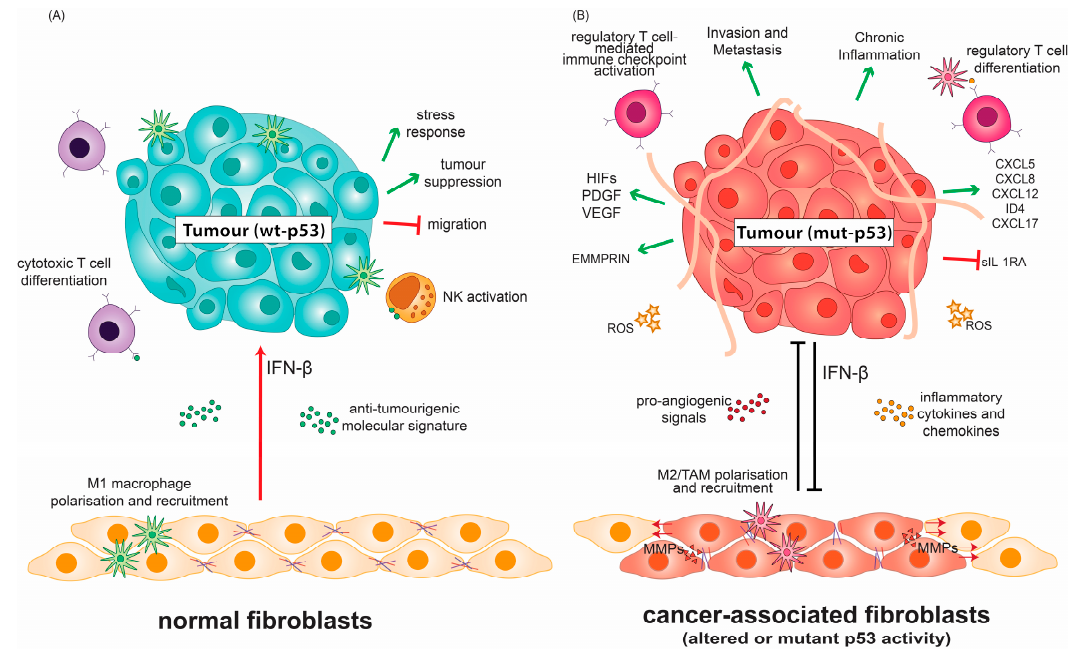
Figure 2. Mutant p53 alters its immunogenic niche. The tumour microenvironment is comprised of cellular and molecular components which shape the immune niche of the growing tumour. ( A ) Normal fibroblasts help mediate immunosurveillance by modulating anti-tumour immune cell infiltration and employing the IFN- β / p53 axis of regulation to activate anti-tumour responses. ( B ) Mutant p53 in the tumour alters the crosstalk between the tumour and its microenvironment, suppressing IFN- β signalling and supporting pro-angiogenic signalling. This altered crosstalk converts normal fibroblasts into tumour-supporting cancer-associated fibroblasts with altered p53 functionality. The altered transcriptional program of cancer-associated fibroblasts (CAFs) supports pro-tumorigenic signalling and extracellular matrix remodelling. The demographic and functionality of infiltrating immune cells is consequently shifted to favour immunosuppression, ultimately leading to a chronically inflamed environment and enhanced migration and